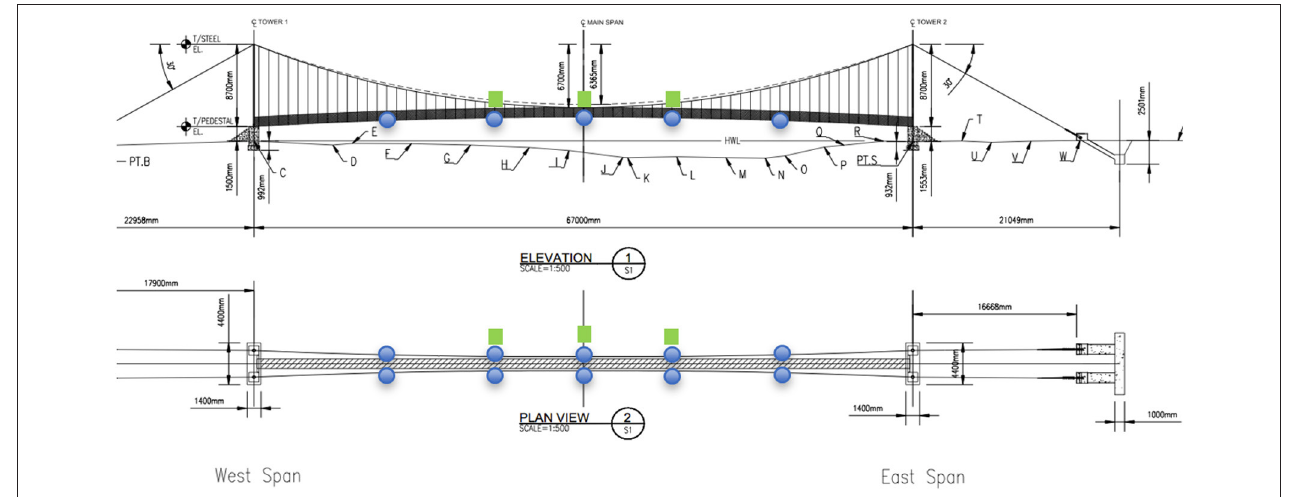
FIGURE 4 | Example of sensor placements of the BDI and Nexus 4 smartphones.